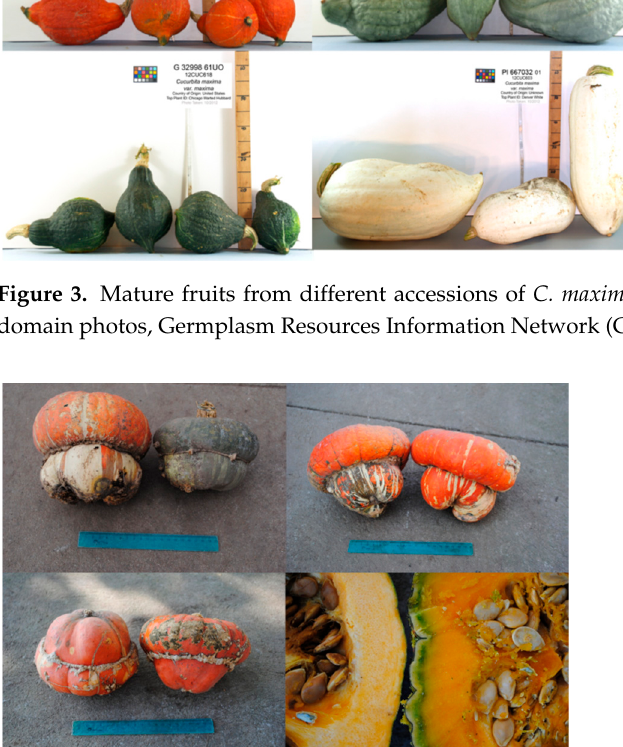
Figure 4. Mature fruits from different accessions of Turban cultivar ‐ group. Blue ruler length 20 cm. Sliced fruits, left light color soft flesh, right more intense color and firm